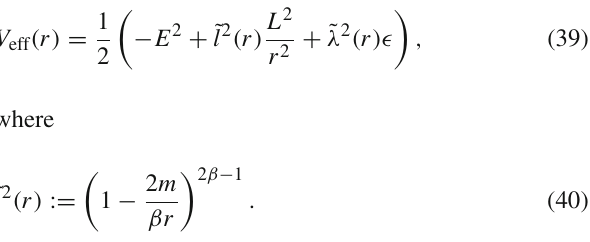
Fig. 7 Upperpanel:timelikegeodesicsparametrizedbythecoordinate time t , with m = 1, E = 0 . 98, L = 4 . 5, for β = 1 (general relativity) versus β = 0 . 88, which corresponds to the lowest value found in our TOV simulations in entangled relativity, for an exotic compact object (i.e. L m = P ) – see Fig. 6. Note that for a more realistic object (i.e. = − ρ or T ), the lowest value has been found to be β = 0 . 975 L m instead – see Fig 3. Lower panel: null geodesics parametrized by the coordinate time t with various impact parameters, with m = 1, for β = 1 (general relativity) versus β = 0 .